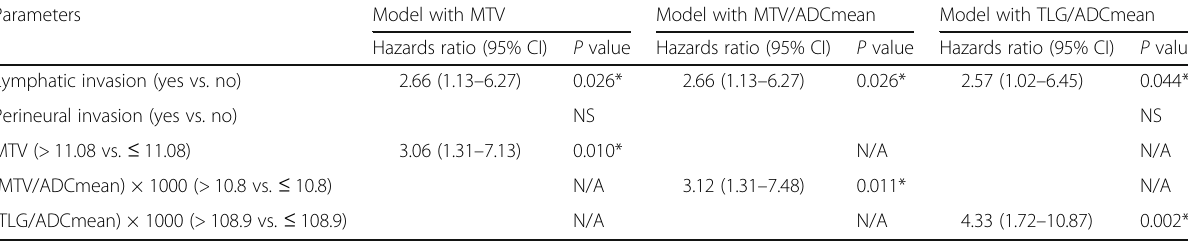
Table 5 Multivariate analysis with significant clinicopathologic and 18 F-PET/MRI parameters Parameters Model with MTV Model with MTV/ADCmean Model with TLG/ADCmean Hazards ratio (95% CI) P value Hazards ratio (95% CI) P value Hazards ratio (95% CI) P value 2.66 (1.13 – 6.27)